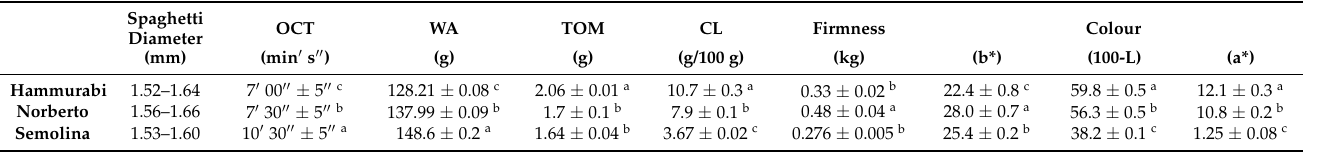
Table 3. Cooking, textural properties, and colour indices of einkorn cv Hammurabi and cv Norberto and semolina pasta.